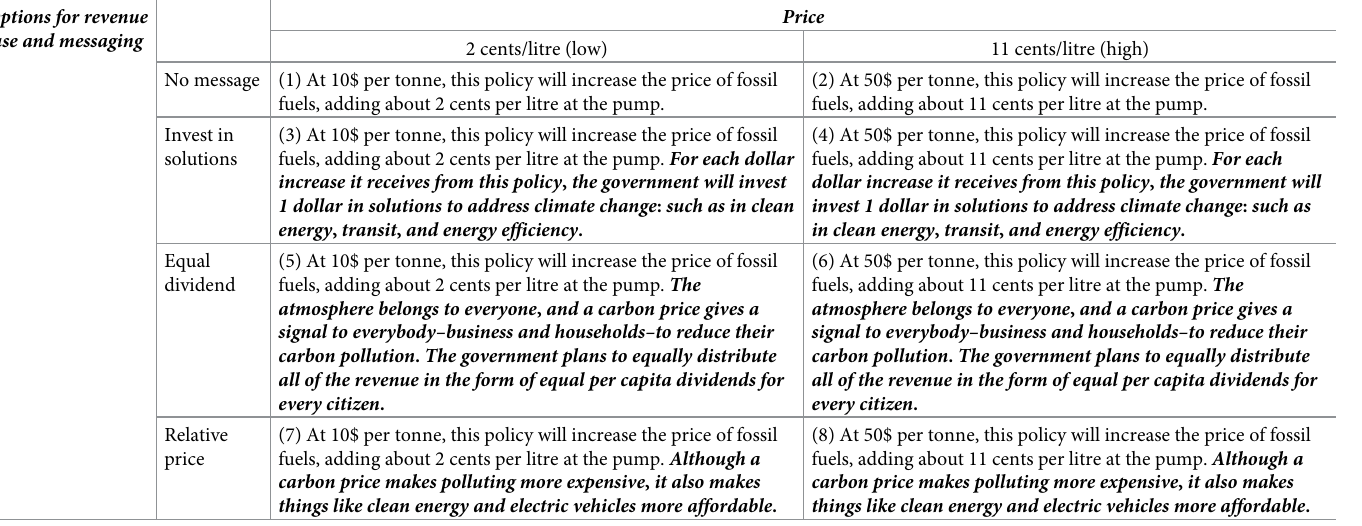
Table 3. Summary of experimental treatments and question